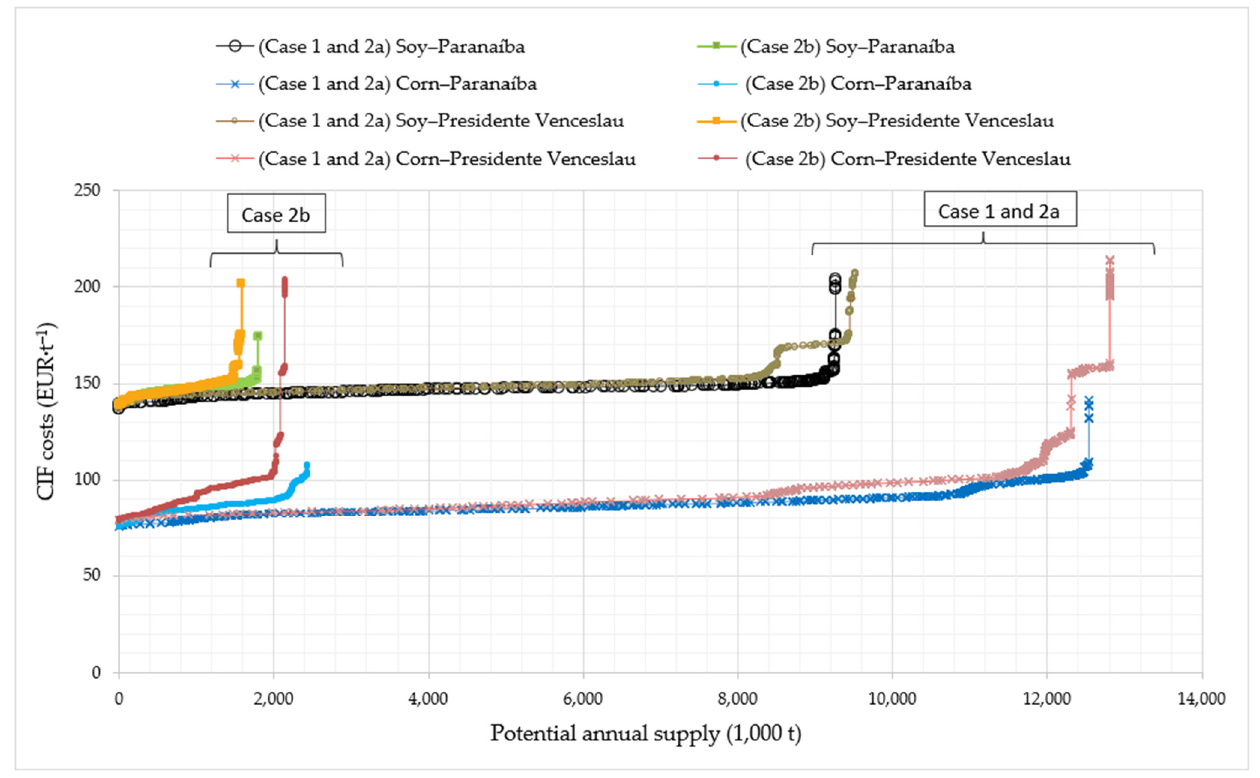
Figure 8. Estimated supply curves for soybean and corn in the center of the two new producing regions: Paranaíba (MS) and Presidente Venceslau (SP). Case 1: only soy production; Case 2a: dou- ble cropping system of soy and corn, and Case 2b: double cropping system, only displacing degraded pasturelands.